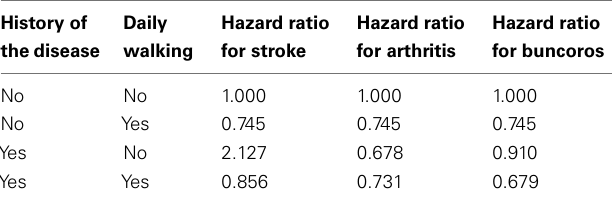
Table 3 | Final stratified multivariate analysis for daily walking data using Cox model.